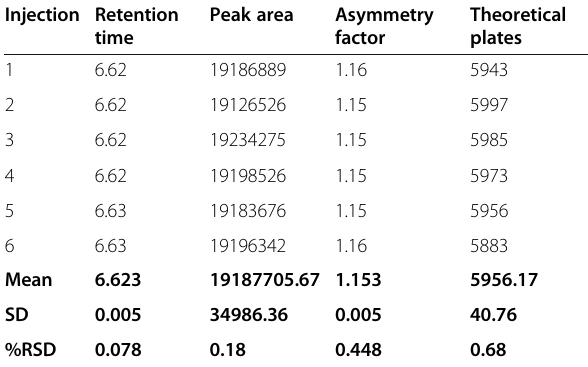
Table 1 System suitability